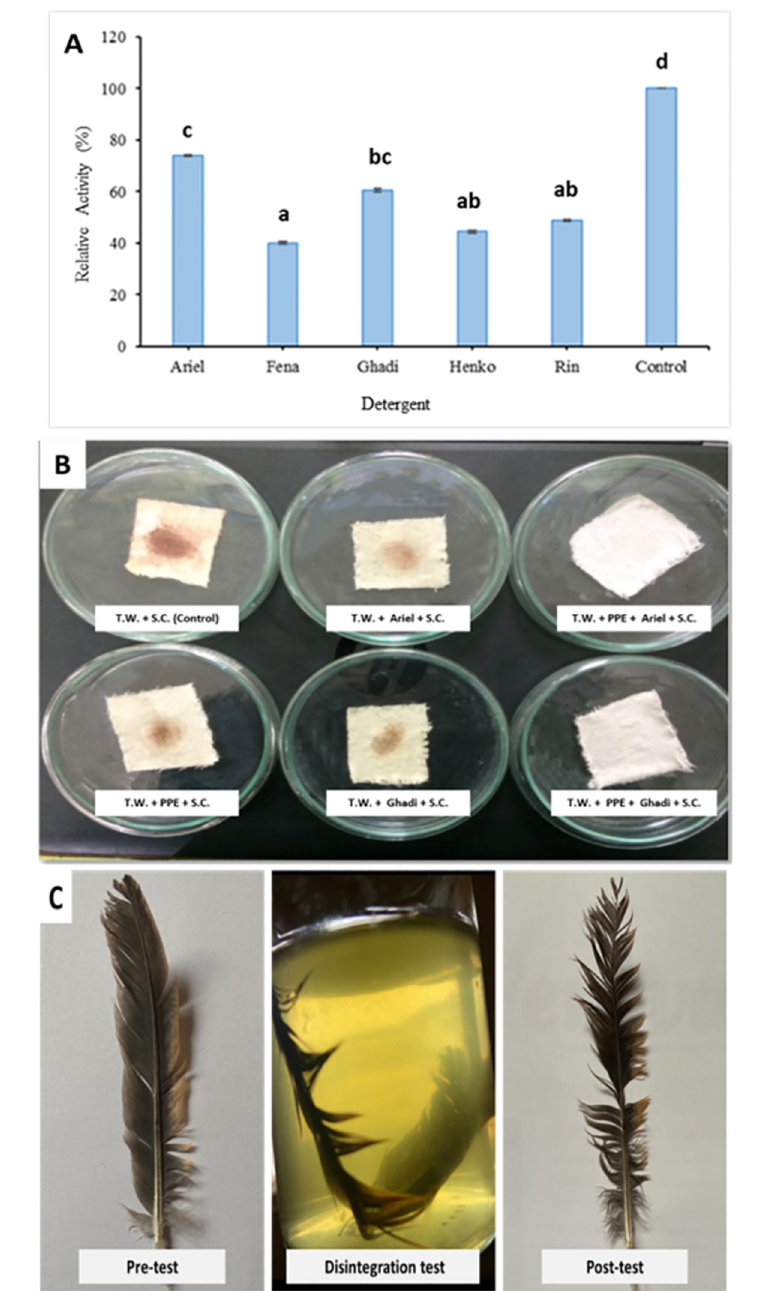
Fig 7. Commercial detergent compatibility test of protease from isolate HM49 (A). Different letters above the bars indicate significant enzyme activity at 0.05 significance level. Blood stain removal test of protease from isolate HM49 (B). Disintegration of chicken feather